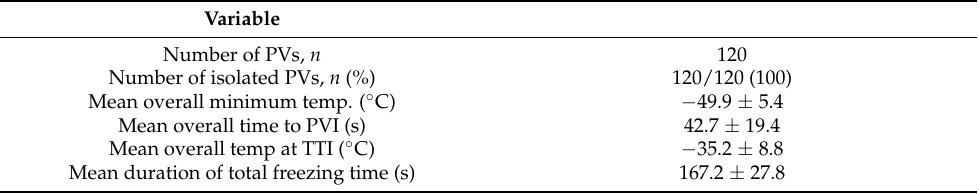
Table 2. Procedural details. Values are expressed as n (%) or mean ± standard deviation. PV(s) = pul- monary vein(s), PVI = pulmonary vein isolation, temp. = temperature, and TTI = time-to-isolation.